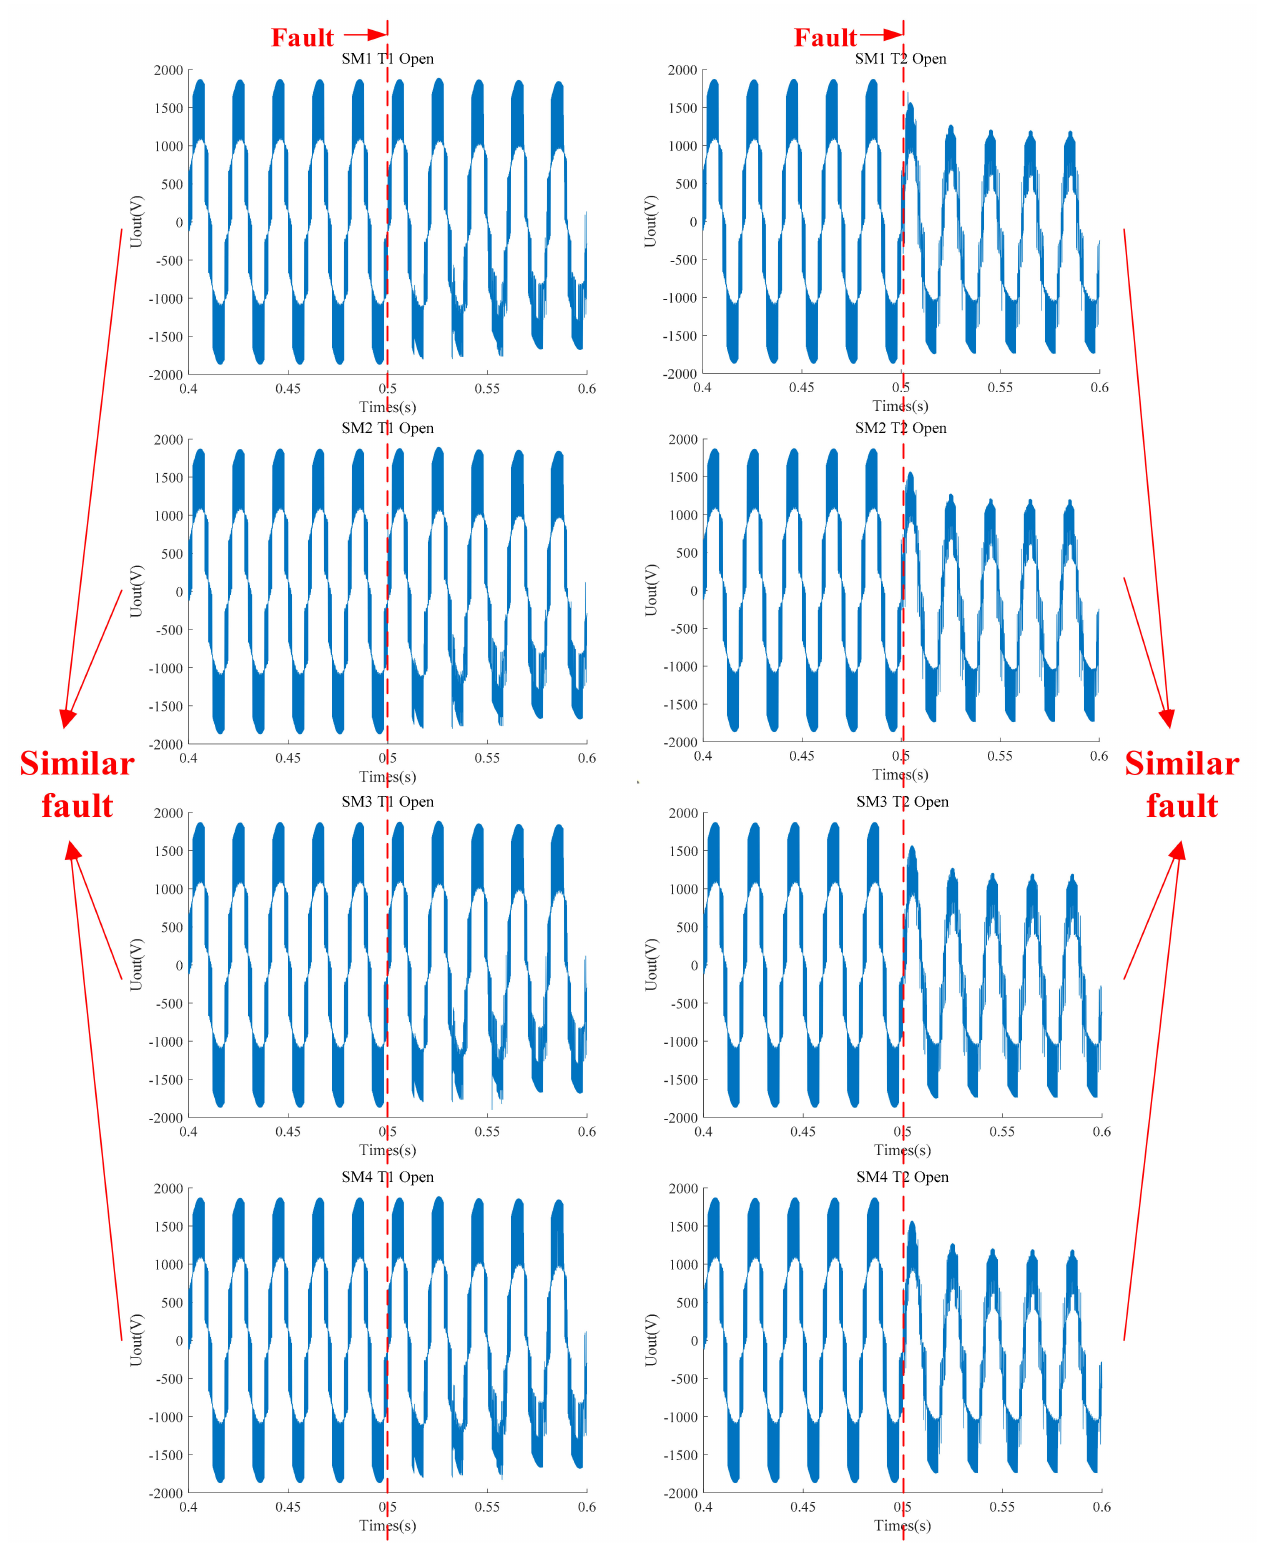
Figure 2. Single-phase output voltage waveforms (fault at 0.5